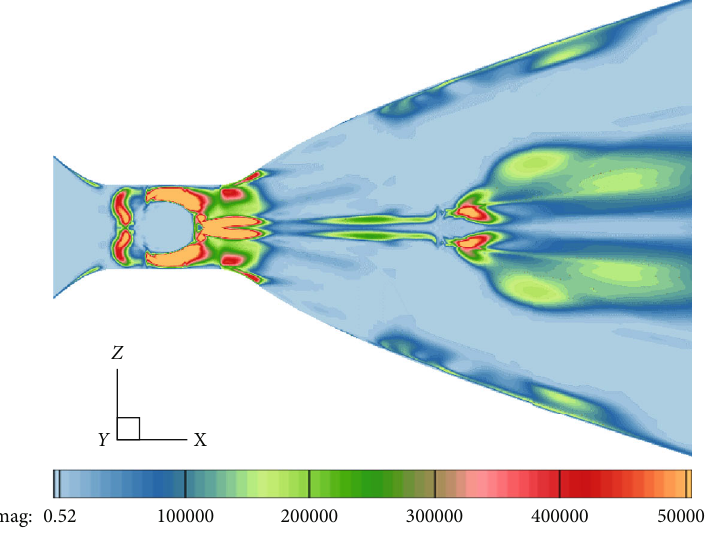
Figure 11: Liutex magnitude contours on y / d = 0 : 11